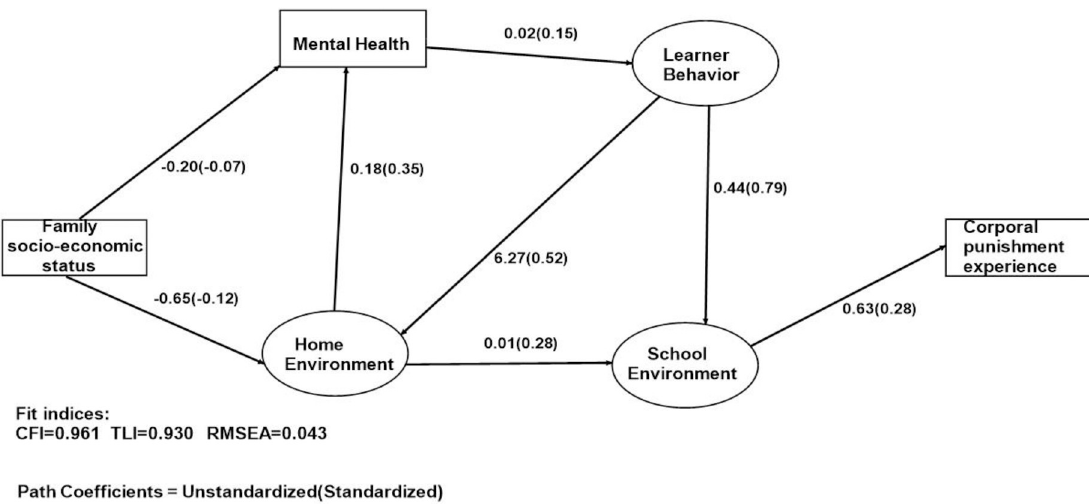
Fig 2. Pathways to experiencing corporal punishment at school among boys.